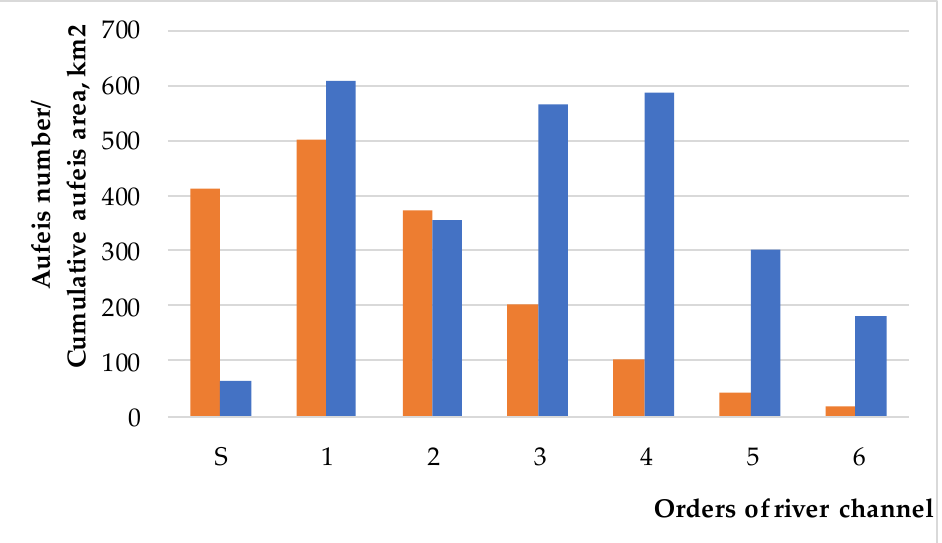
Figure 7. Plot of Aufeis number (red) versus cumulative Aufeis area (blue) relative to the orders of the river channels in the Kunlun Mountains. S refers to the sloping Aufeis at the abscissa axis.